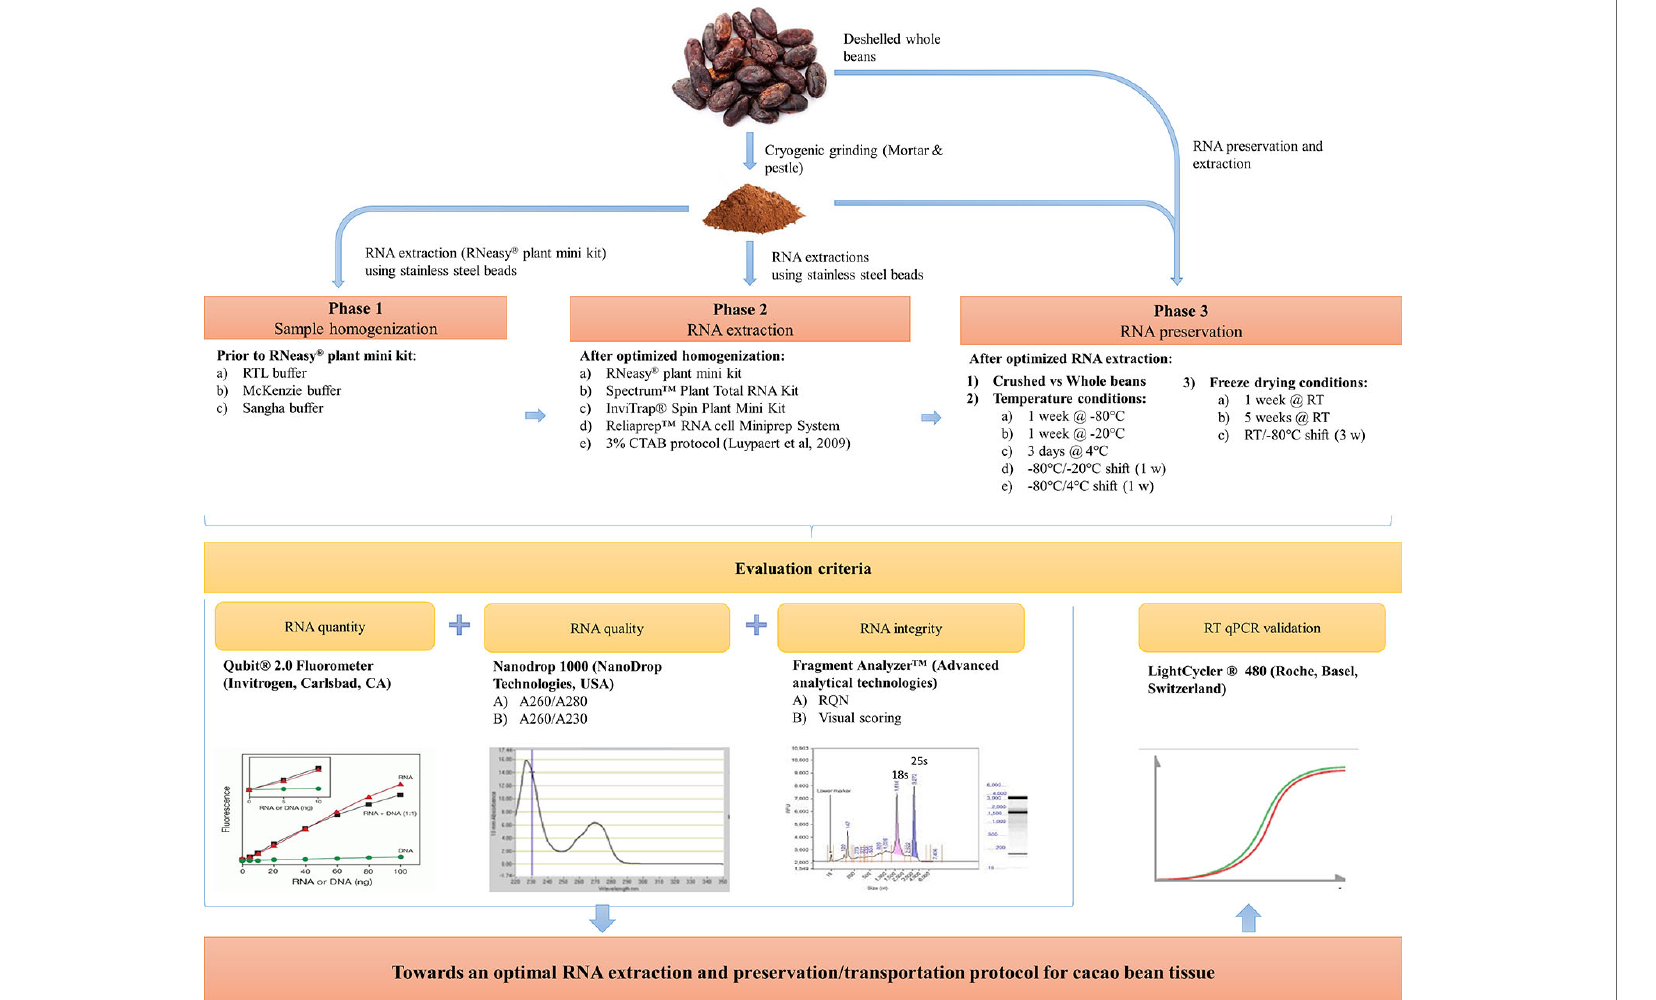
FIGURE 1 | Schematic overview towards an ef fi cient sample homogenization, RNA extraction, and preservation method for cacao bean